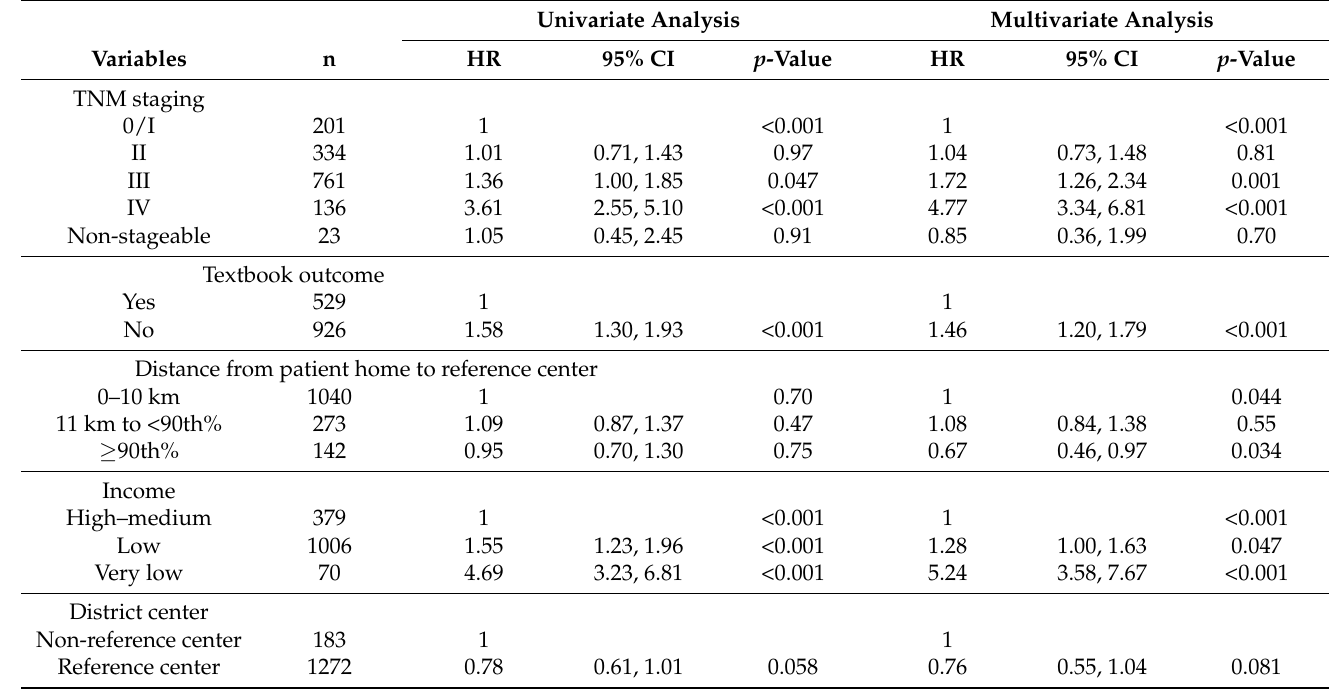
Table 4. Cont. Univariate Analysis Multivariate